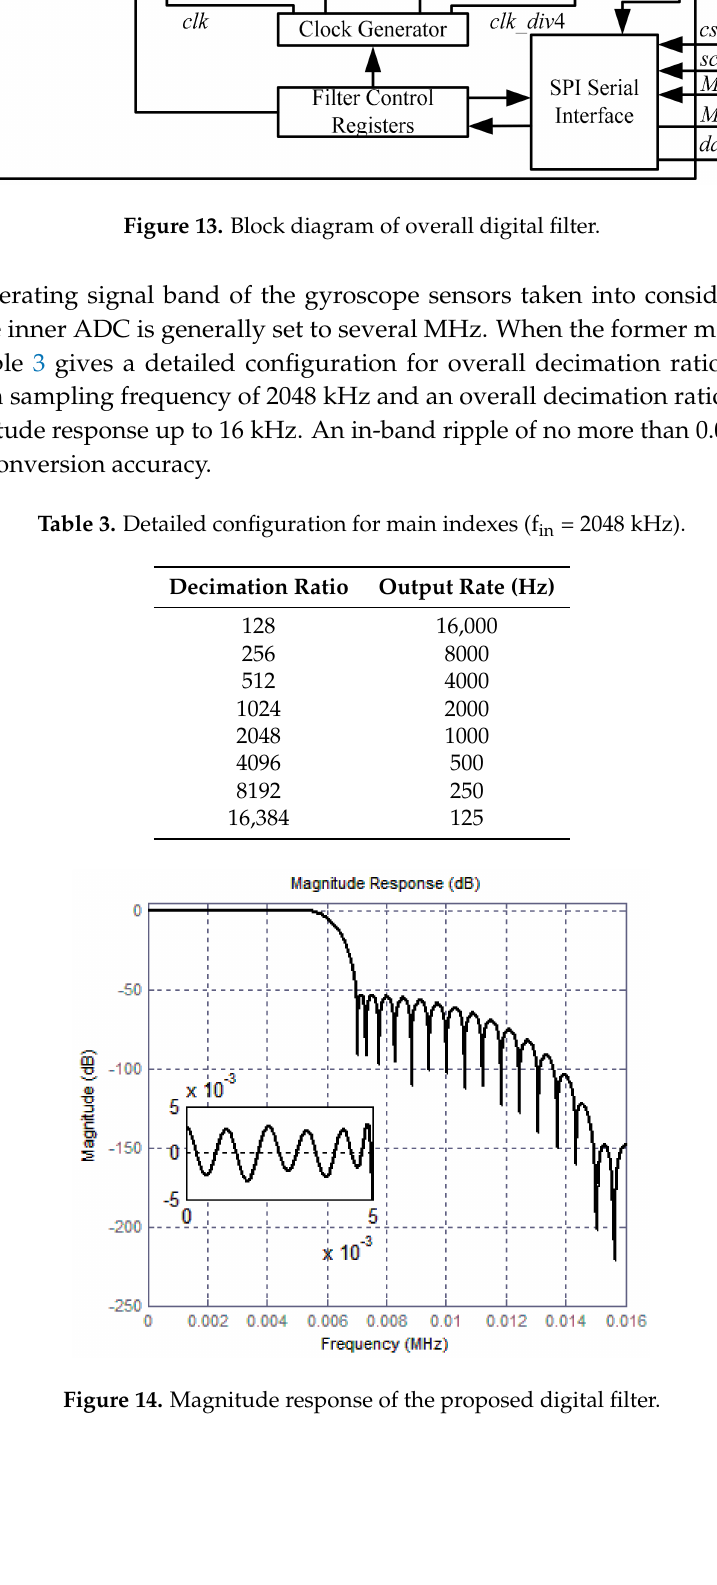
Figure 14. Magnitude response of the proposed digital